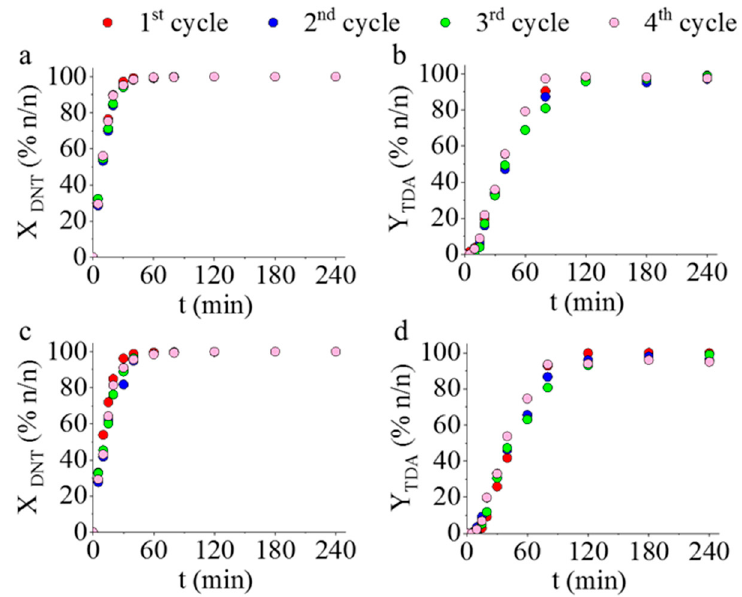
Figure 8. Reuse tests of the Pd/CoFe 2 O 4 -NH 2 ( a , b ) and Pd/NiFe 2 O 4 -NH 2 ( c , d ) catalysts. Change of the 2,4-DNT conversion and 2,4-TDA yield vs. time of